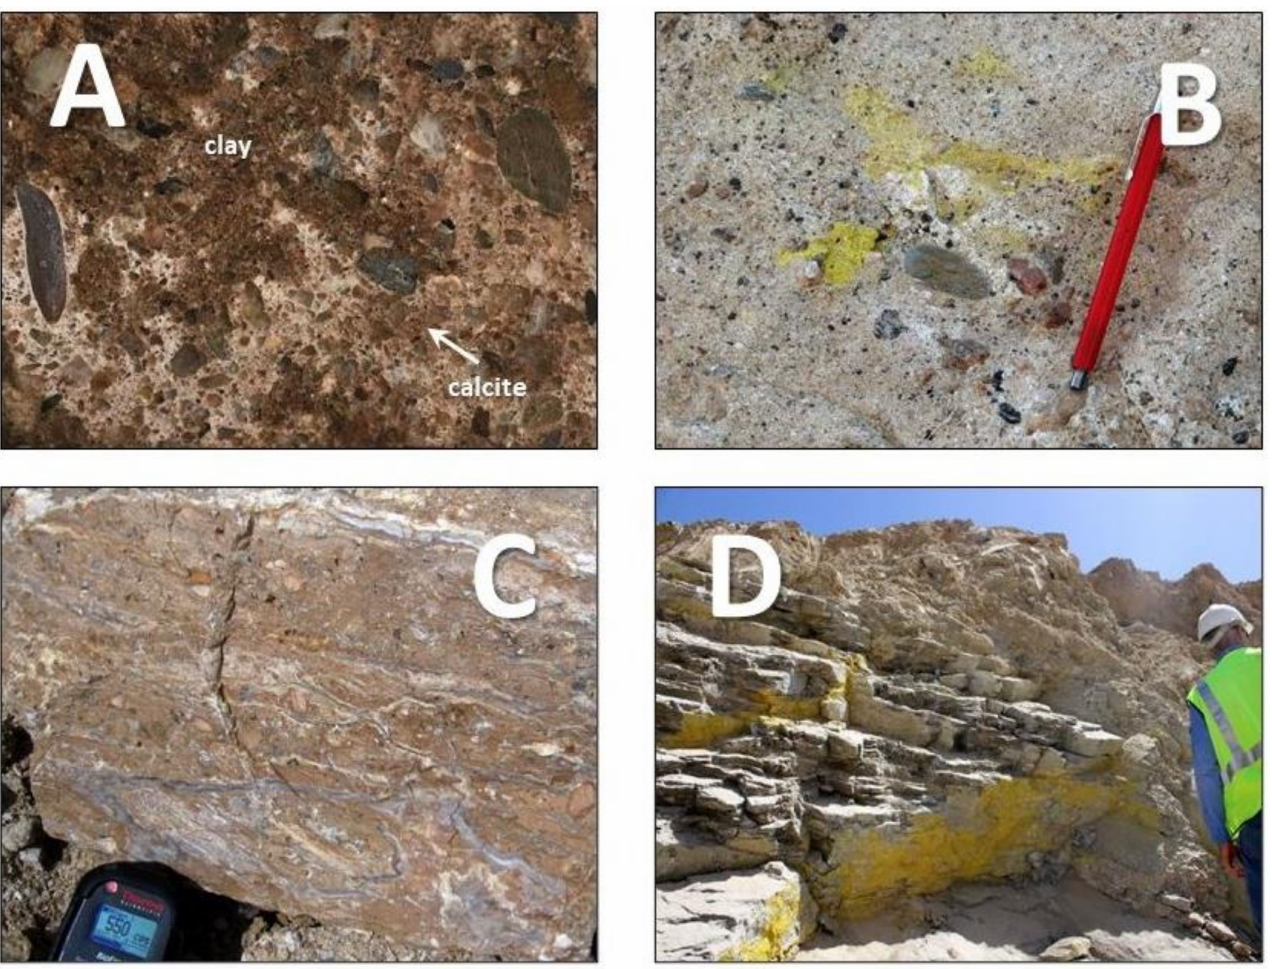
Figure 7. ( A )—carbonate-cemented conglomerate from Tumas. Note the irregular distribution of pale calcite-cemented areas. The dominant cement is noted. ( B )—Mineralised and calcite-cemented polymictic conglomerate from Langer Heinrich. Yellow colour is carnotite. Note the erratic distri- bution of the carnotite. ( C )—Silicified conglomerate, Trekoppje open pit. ( D )—Carnotite crusting sub-vertical fractures in schist of Tinkas formation at Langer